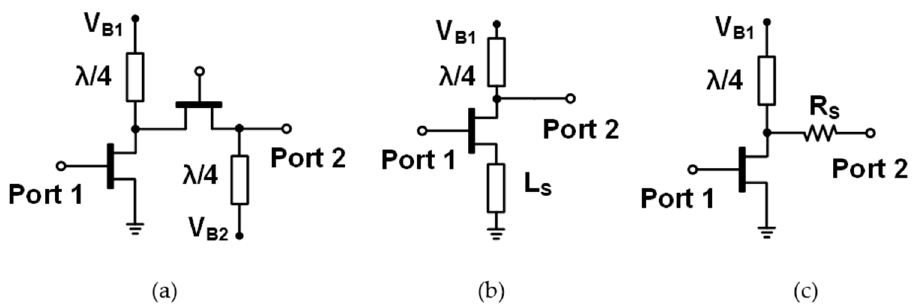
Figure 2. Stability enhancement configurations: ( a ) a cascode stage, ( b ) a single stage with source degeneration, and ( c ) a single stage with an output series resistor.